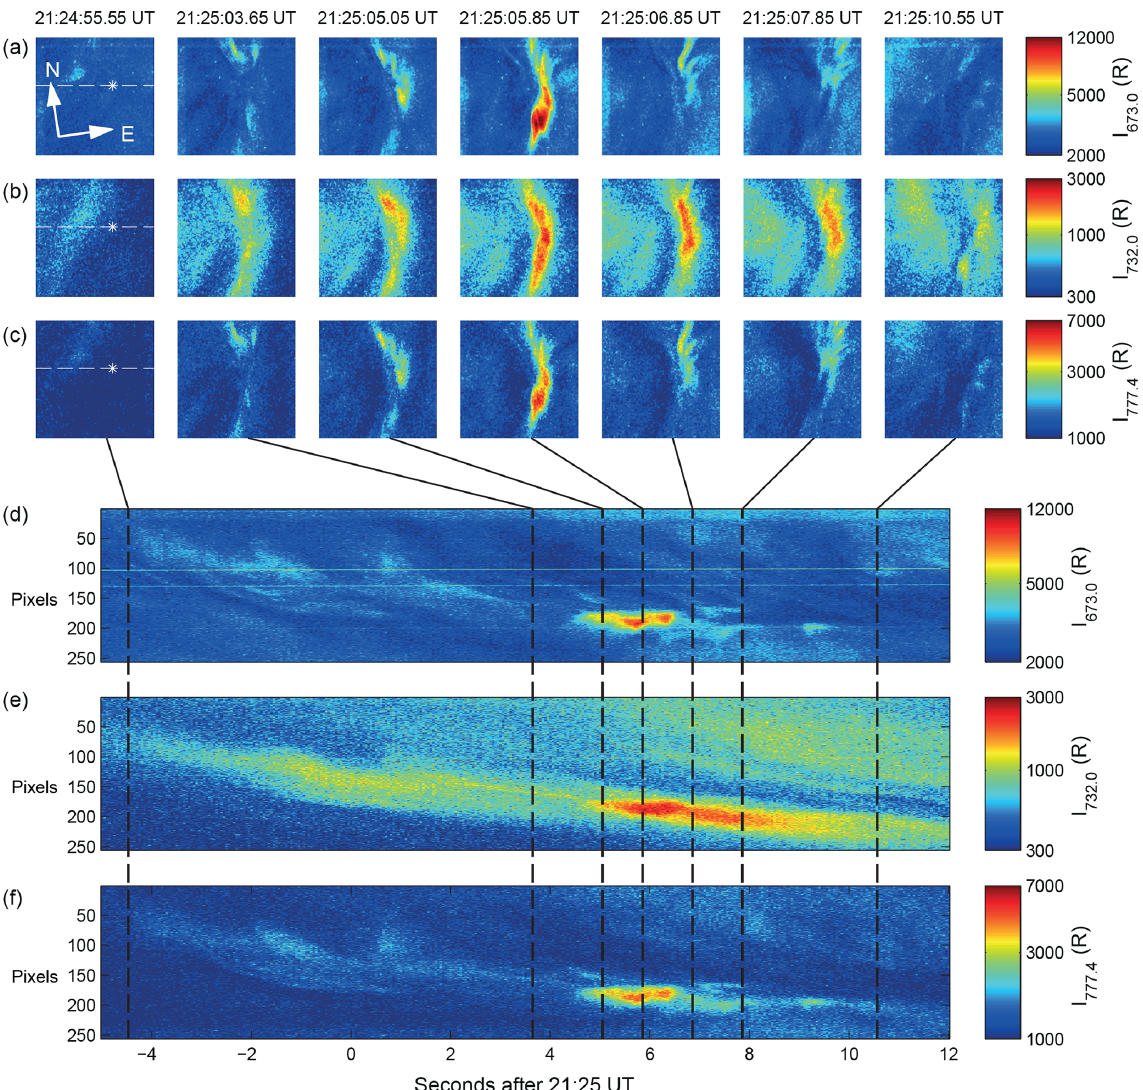
Figure 1. (a–c) Images of the auroral brightness observed by ASK1 (N 2 , I 673 . 0 ), ASK2 (O + , I 732 . 0 ) and ASK3 (O, I 777 . 4 ) respectively. The asterisk is the position of the magnetic zenith, and the dashed lines are the position and orientation of the slices below. (d–f) Stack plots of west–east slices, five pixels wide, through images from ASK1, ASK2 and ASK3 respectively. The black lines link the images to the selected times. Logarithmic intensity scales are used to highlight both bright and faint features throughout the